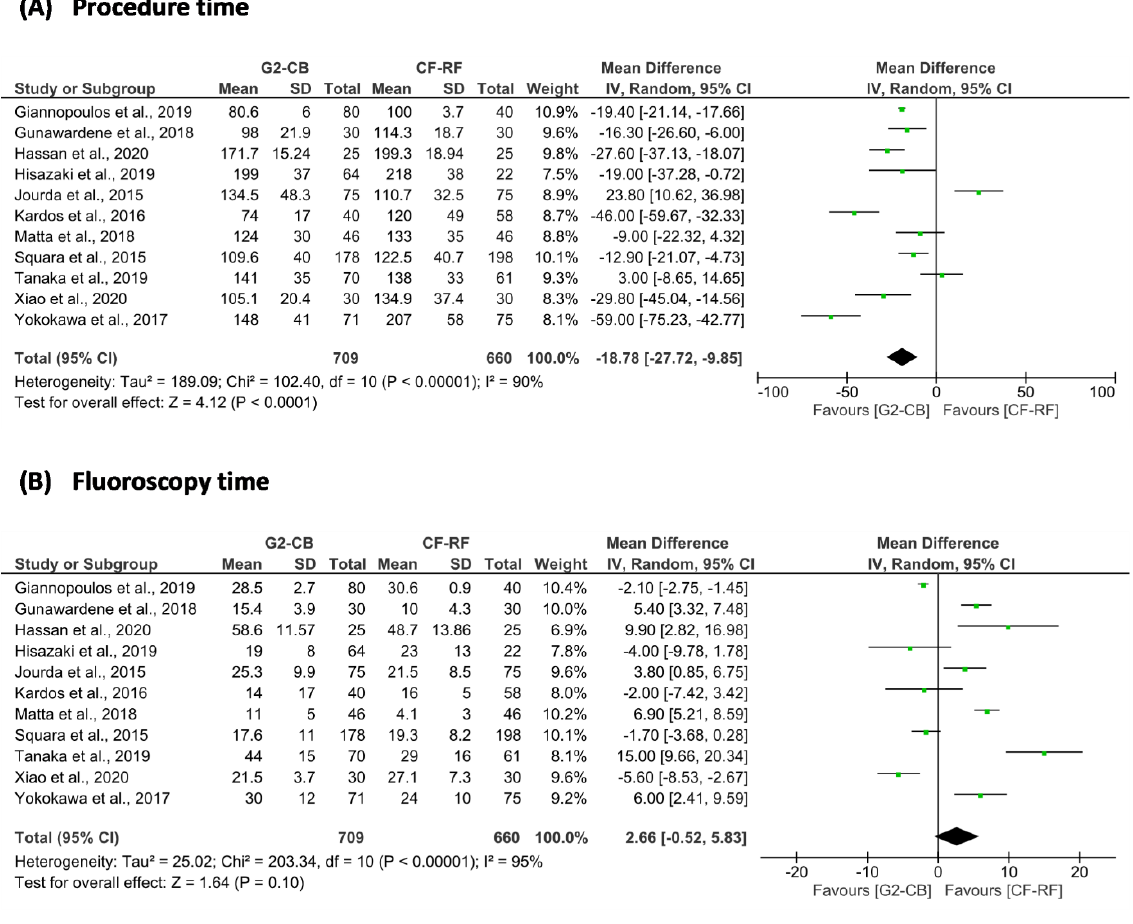
Figure 3. Forest plot of ( A ) procedure time and ( B ) fluoroscopy time; 2G-CB = second-generation cryoballoon; CF-RF = contact force-sensing radiofrequency; CI = confidence interval; IV = inverse variance; SD = standard deviation.